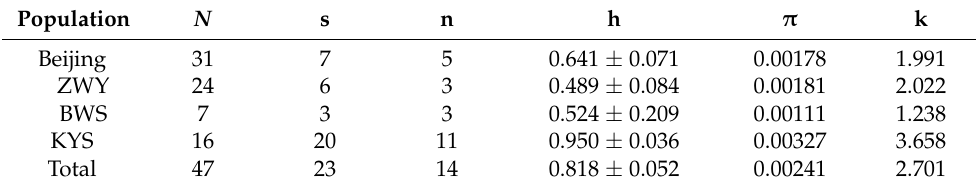
Table 1. Genetic diversity of Bombina orientalis populations based on mitochondrial DNA. Population